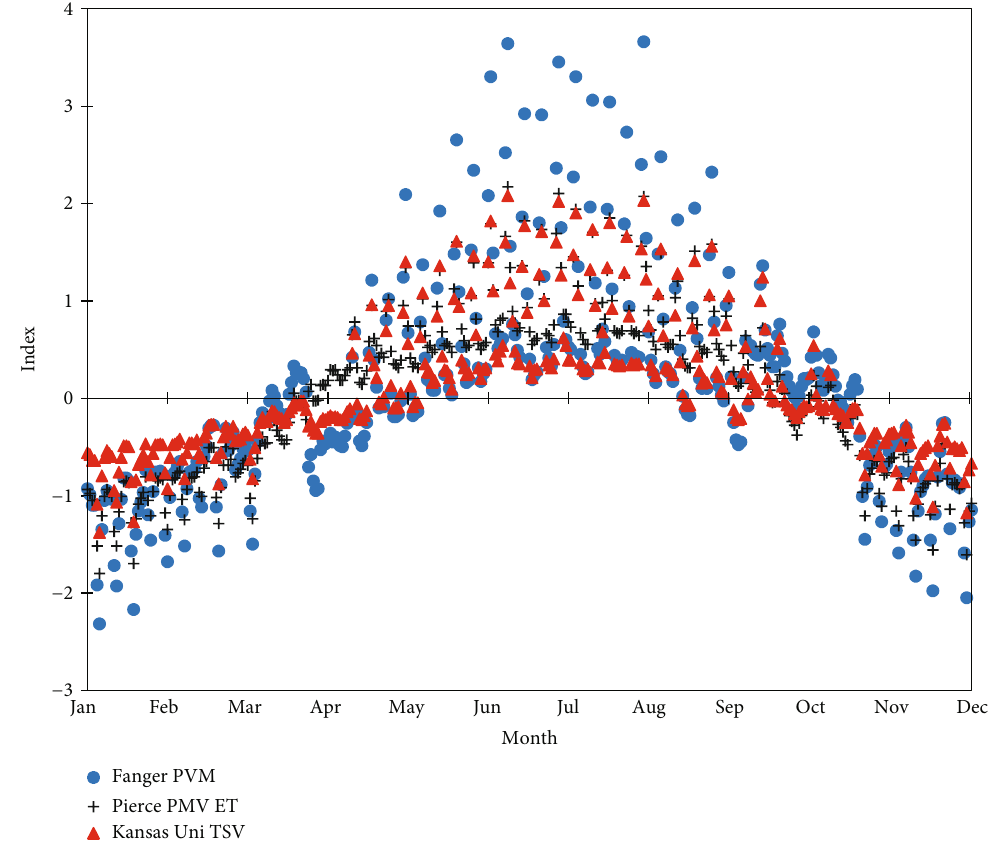
Figure 19: Comparison of thermal comfort in the studied building using three di ff erent